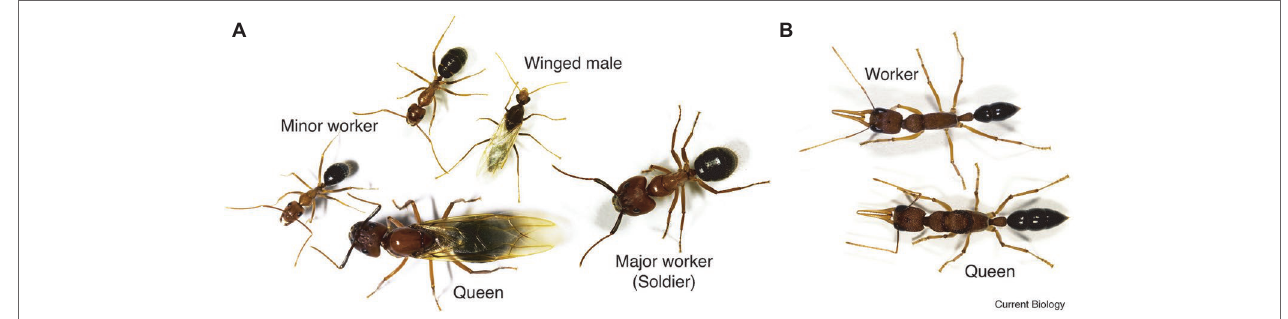
FIGURE 1 | Caste polyphenism in ants. (A) Camponotus floridanus , a winged (virgin) queen (bottom, center); a (winged) male (top, center), a major worker (soldier) on the right, and two minor workers (bottom left and top left). (B) Harpegnathos saltator , a worker (top) and queen (bottom). (Reproduced with permission from Chittka et al., 2012).